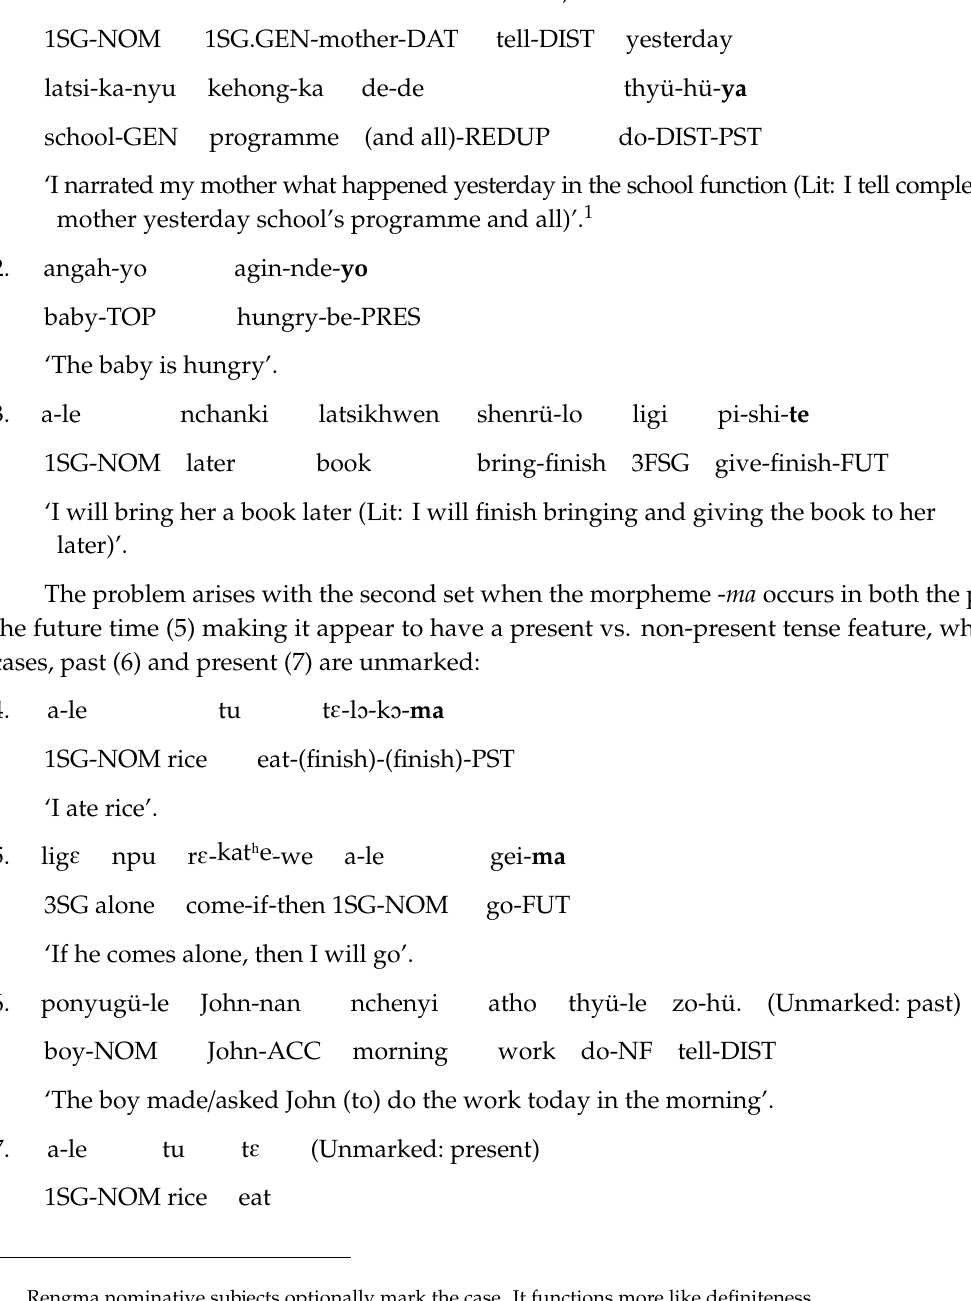
Table 1. Tense marking in Rengma. Past Present